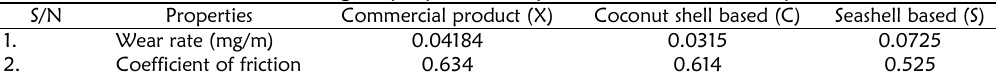
Table 7: Tribological properties of optimised and control sample